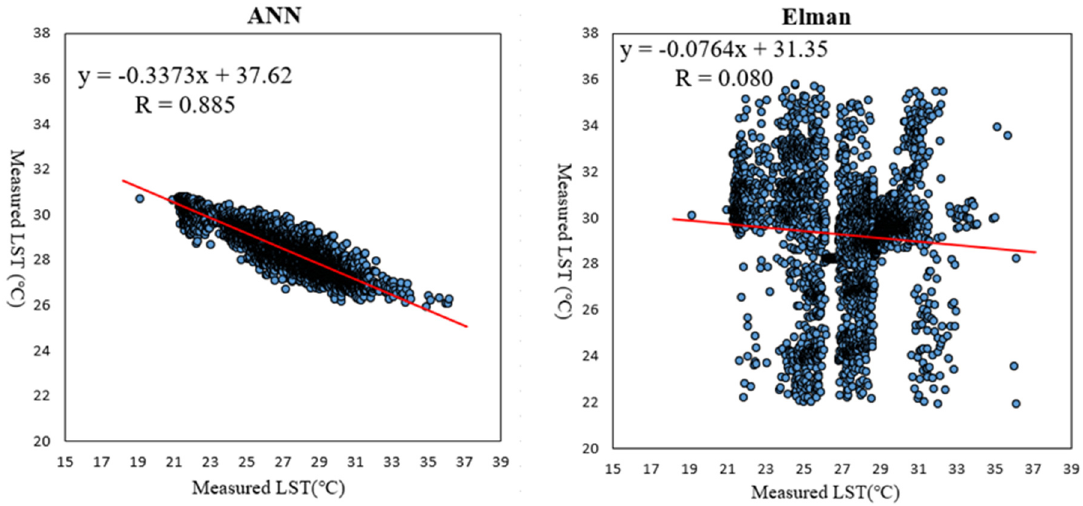
Figure 2. Testing performance of ANN and Elman for measured LST in 2020.